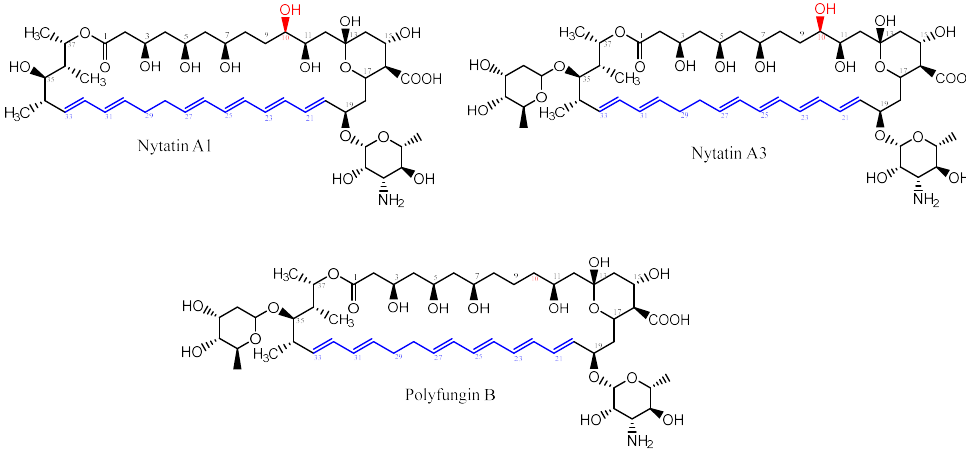
Figure 1. Chemical structures of nystatin A1, A3, and polyfungin B.